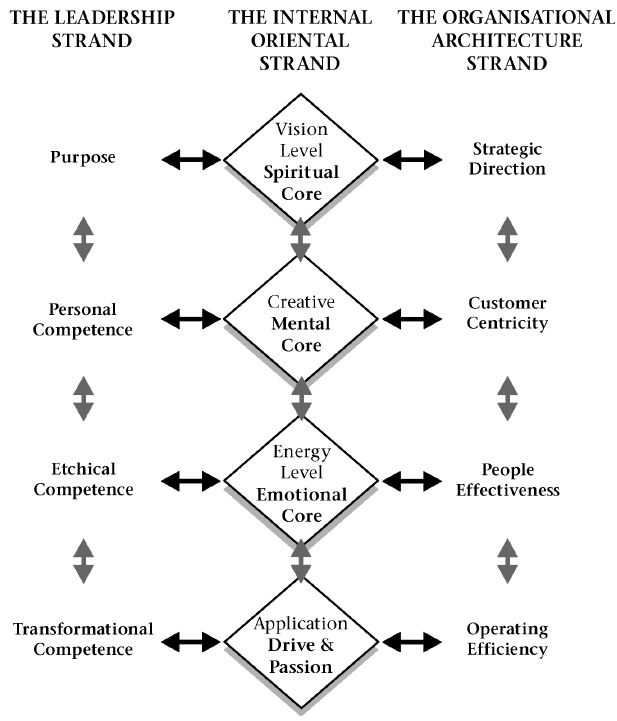
Figure 6: The Integrated Genetic Business Code Model T ABLE